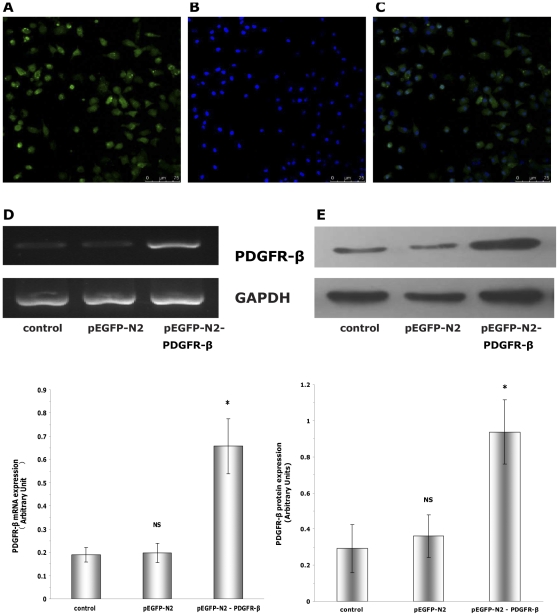
Overexpression of PDGFR-β in transfected EPCs.(A,B,C) Transfected cells can be identified using an in-vector marker, EGFP 21 h after transfection, the expression of EGFP was detected by laser scanning confocal microscopy in the pEGFP-N2-PDGFR-β group (A), and nuclei were stained with DAPI (B). The transfection efficiency (number of green cells/total number of cells) was about 50-60%. Scale bar = 75 µm. (D,E) 72 h post-transfection, PDGFR-β mRNA (D) and protein levels (E) in the pEGFP-N2-PDGFR-β group were significantly higher than in the control group or pEGFP-N2 group.* P<0.01 vs. control or pEGFP-N2; NS, no significant vs. control (n = 3).